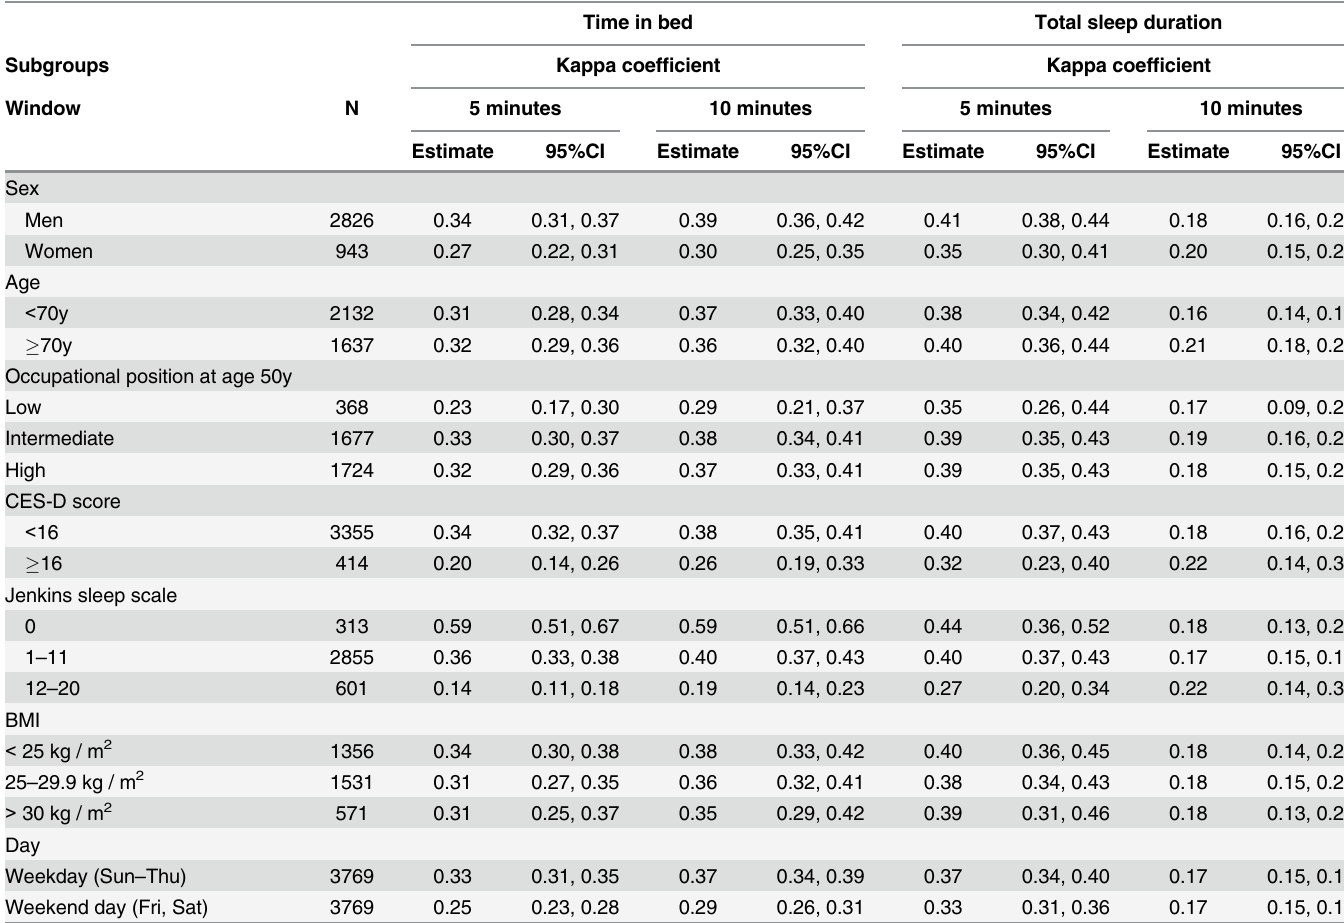
Table 2. Agreement between sleep duration categories estimated by sleep survey questionnaire and by accelerometer methods in different